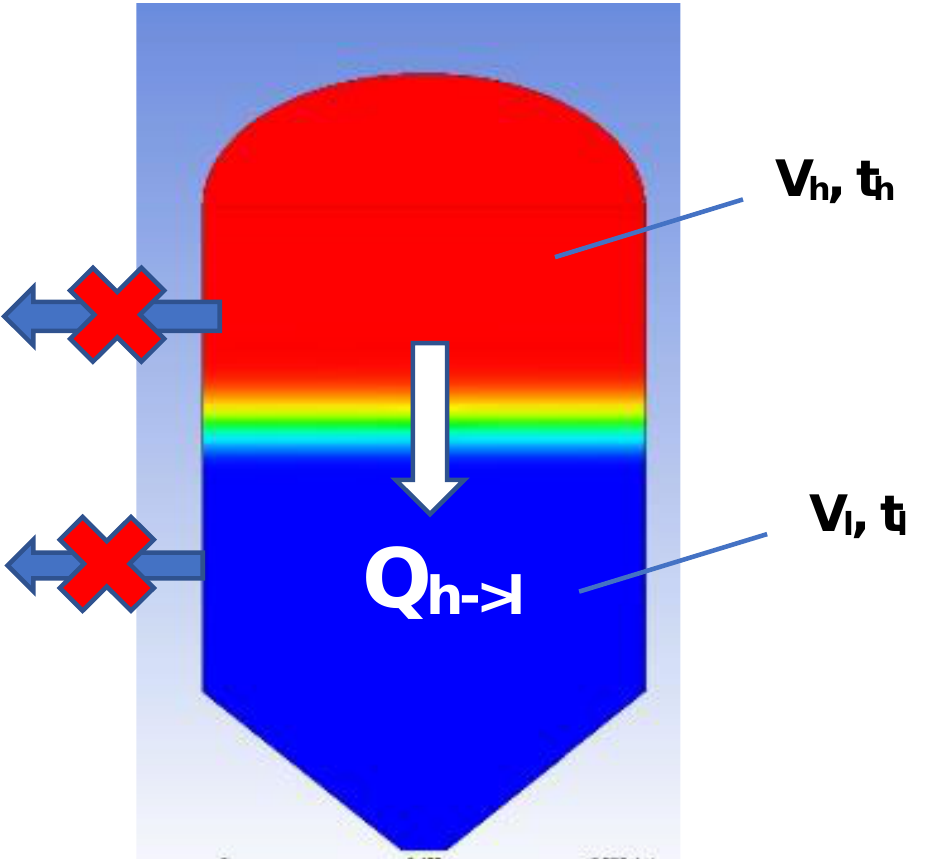
Figure 5. The concept of the model to determine heat losses through the thermocline by blocking external heat transfer fluxes.